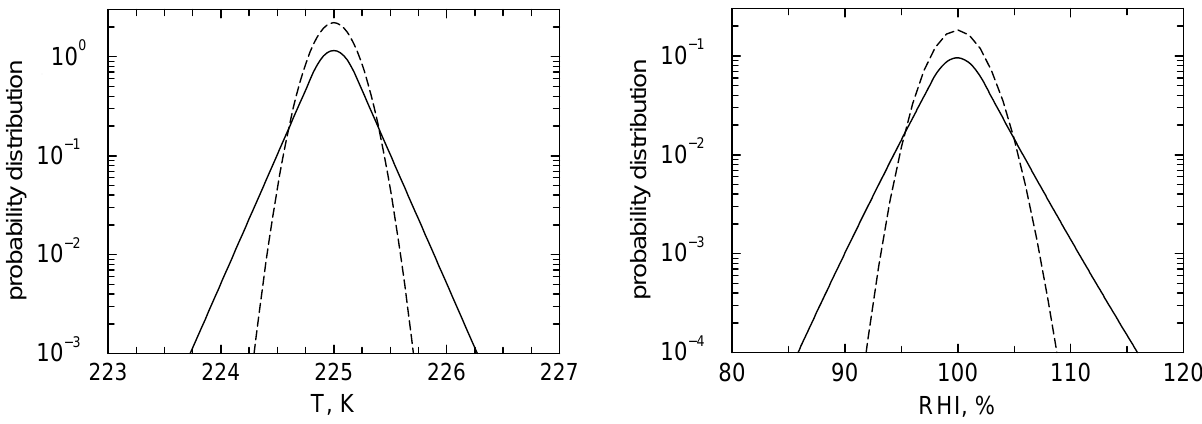
Fig. 8. Comparison between a temperature distribution arising from mesoscale temperature fluctuations with characteristic horiziontal scale of 12 . 8 km (Bacmeister et al., 1999) and the resulting distribution of RHI (solid curves, left and right panel, respectively) with corresponding solutions for an equivalent Gaussian temperature distribution (dashed curves).